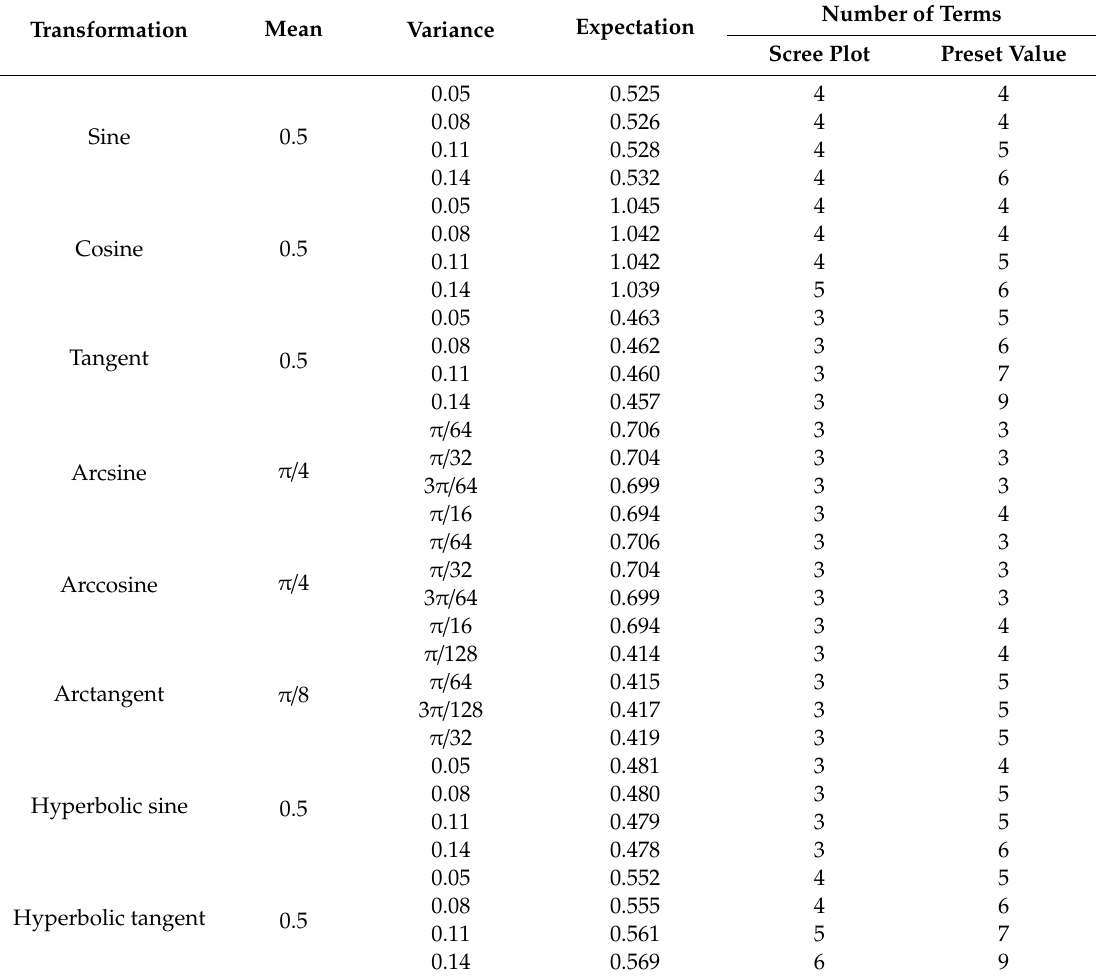
Table 1. E ffi cient Taylor series expansion converges according to the scree plot and to the preset value of 10 − 5 . Mean and variance of ξ from Equation (1) mirror the values from Strimbu, Amarioarei, and Paun [29]. The values for mean are in radians. The expectation is the inverse of the transformation computed with Equations (2) and